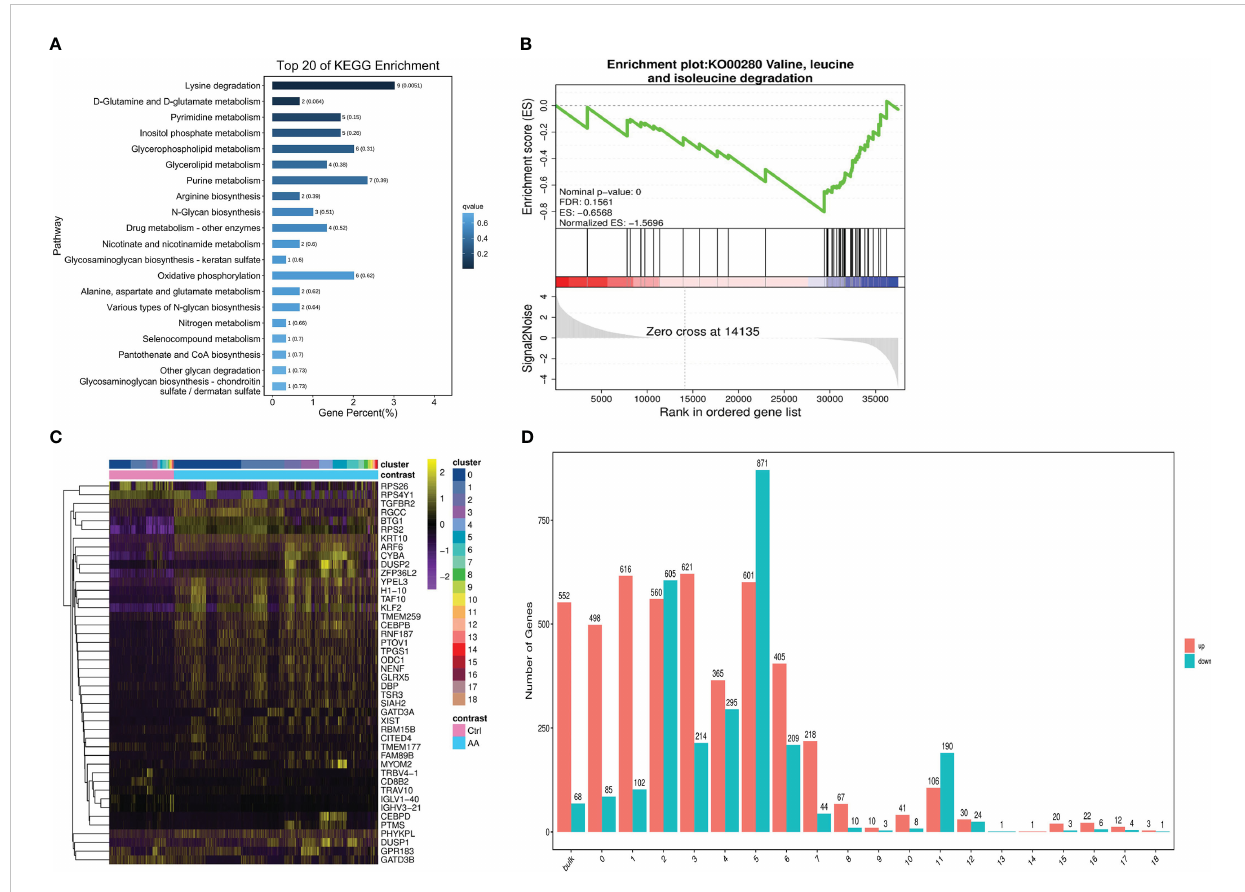
FIGURE 4 scRNA-seq revealed metabolic differences in AA. Bar chart showing top 20 of the KEGG pathway enriched in cell metabolism compared to those in the control group (A) . Gene set enrichment analysis (GSEA) plots of valine, leucine, and isoleucine degradation differences in AA patients compared with those in healthy donors (B) . Heat map of differential genetic expression handled with the z-score to normalize gene expression (C) . Bar chart showing the number of up- or downregulated genes in bulk and 19 subsets. Red indicates upregulation, and green indicates downregulation (D)